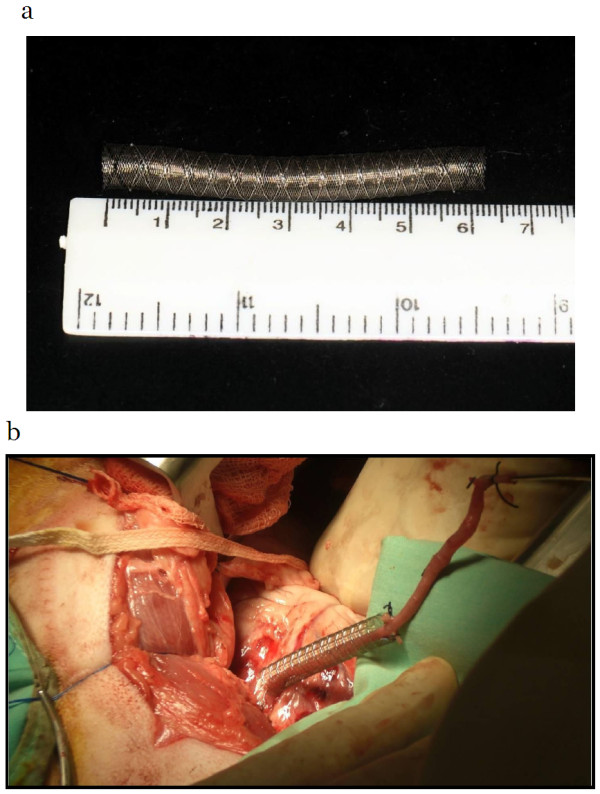
The compressed external support device. a: Expandable support device in its compressed configuration. b: The device is mounted on the vein graft after first anastomosis.